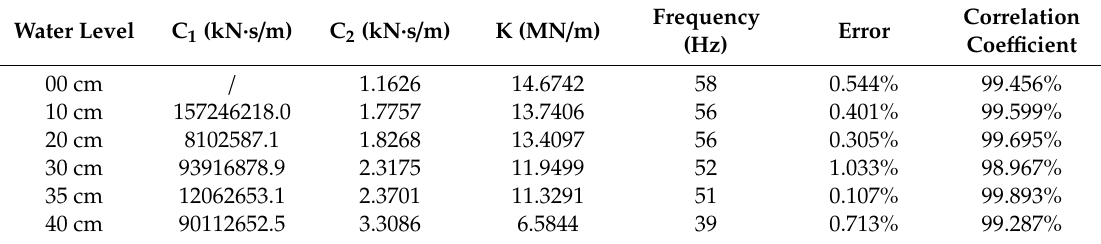
Table 4. Dynamic properties of ballast based on Model-2 (using concrete sleeper).